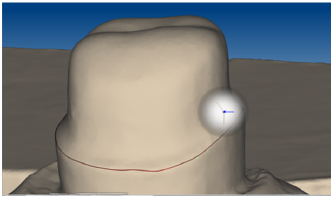
Figure 1. Marking the preparation margin on the scanned abutment tooth.